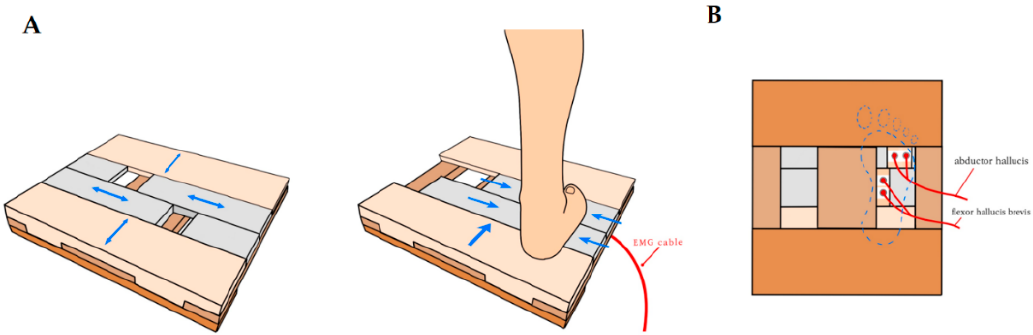
Figure 2. Developed EMG foot plate: ( A ) top view, ( B ) bottom view.